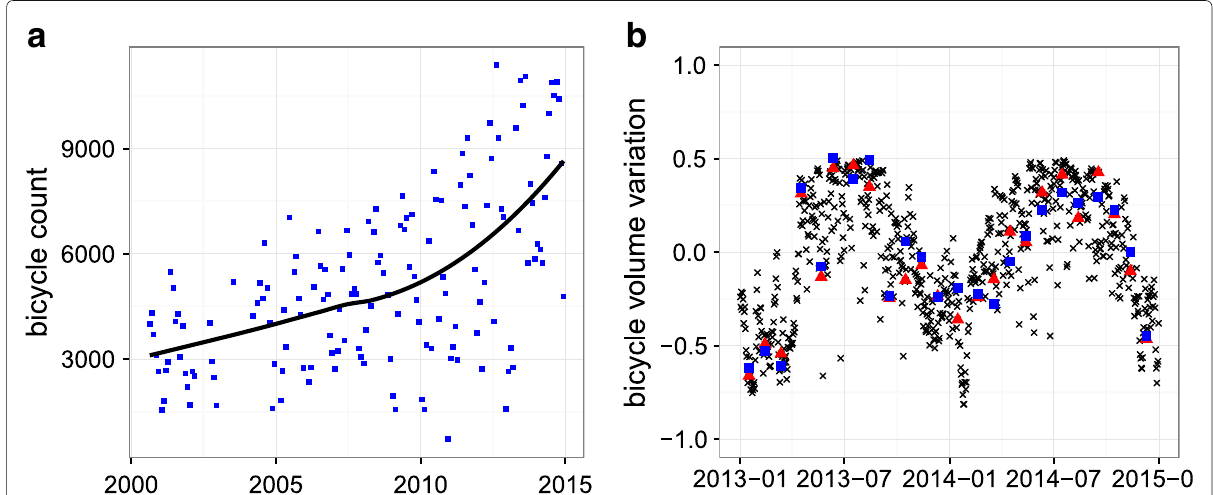
Fig. 3 a Slowly varying average bicycle count P ( t ) obtained by local regression (solid black curve) and monthly bicycle counts (blue squares) for the location “Kreuzberg”; b Predictions of the bicycle volume model for the deviation W ( t j ) (red triangles at the monthly count dates and black crosses, otherwise) and the blue squares indicate the observed numbers w j during monthly bicycle counts